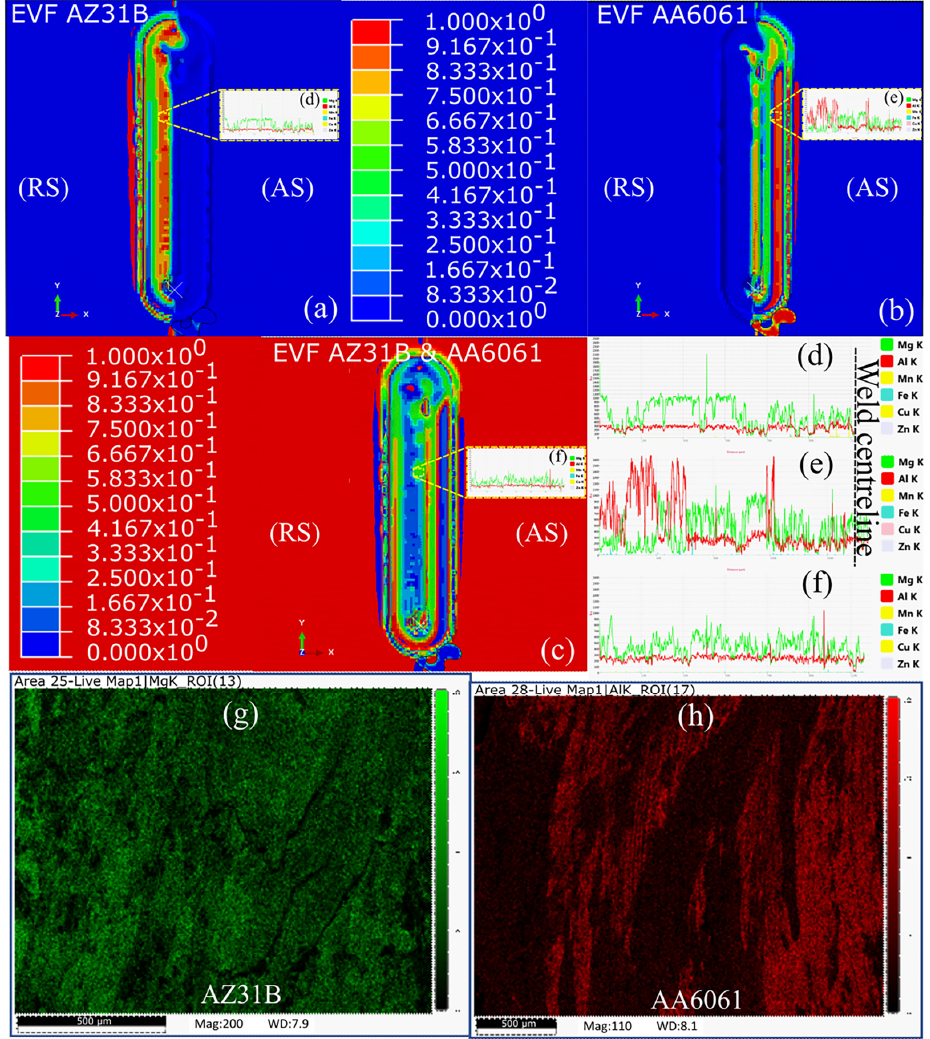
Figure 4. Numerical modeling of the material mixing on ( a ) RS, ( b ) AS, and ( c ) SZ; the EDS line scan on ( d ) RS, ( e ) AS, and ( f ) SZ; elemental mapping on ( g ) RS and ( h ) AS [Welding conditions 900 rpm and 30 mm/min].